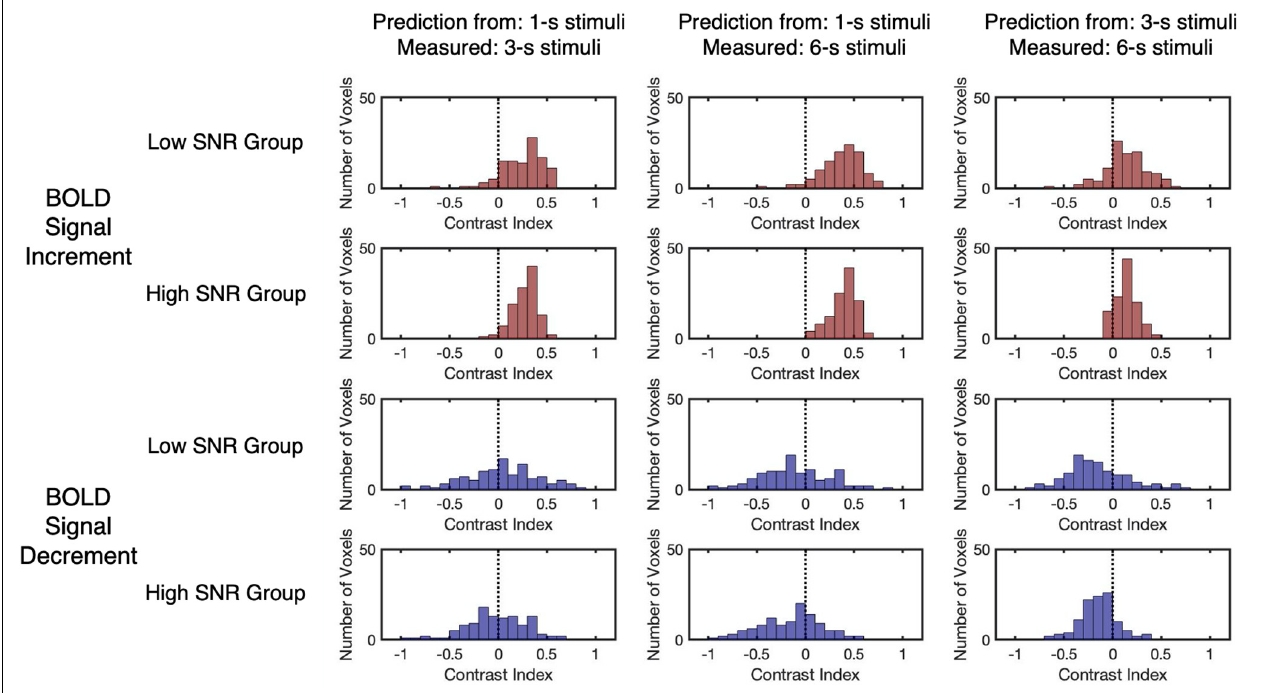
FIGURE 6 | The distributions of the contrast index for the low SNR group and high SNR group. The low SNR group ( n = 111) and high SNR group ( n = 112) were split by the median r 2 of the corresponding BOLD response type. The vertical dashed lines indicate that the contrast index equals 0. Each data point refers to the contrast index of one selected